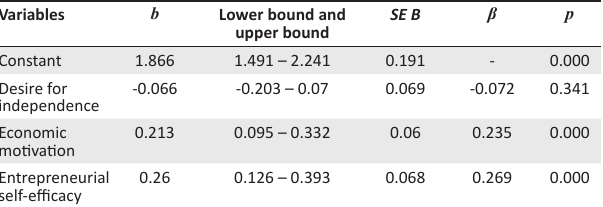
TABLE 1: Linear model of predictors of willingness to become an entrepreneur.